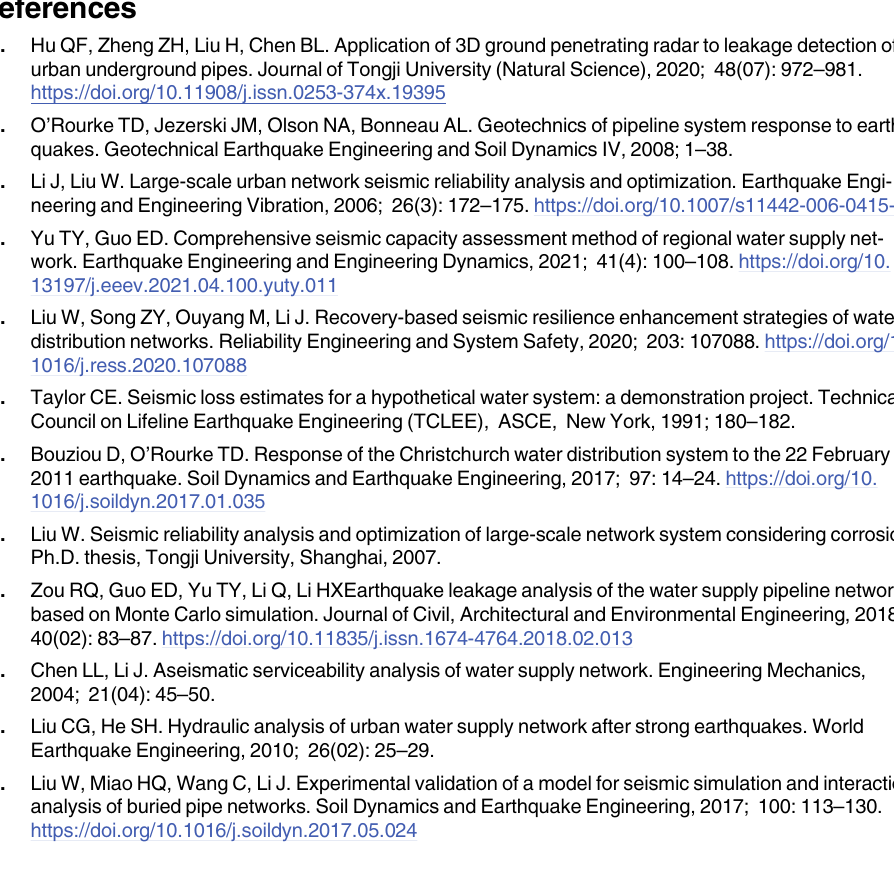
S4 Table. Probability of complete damage of each pipe section based on